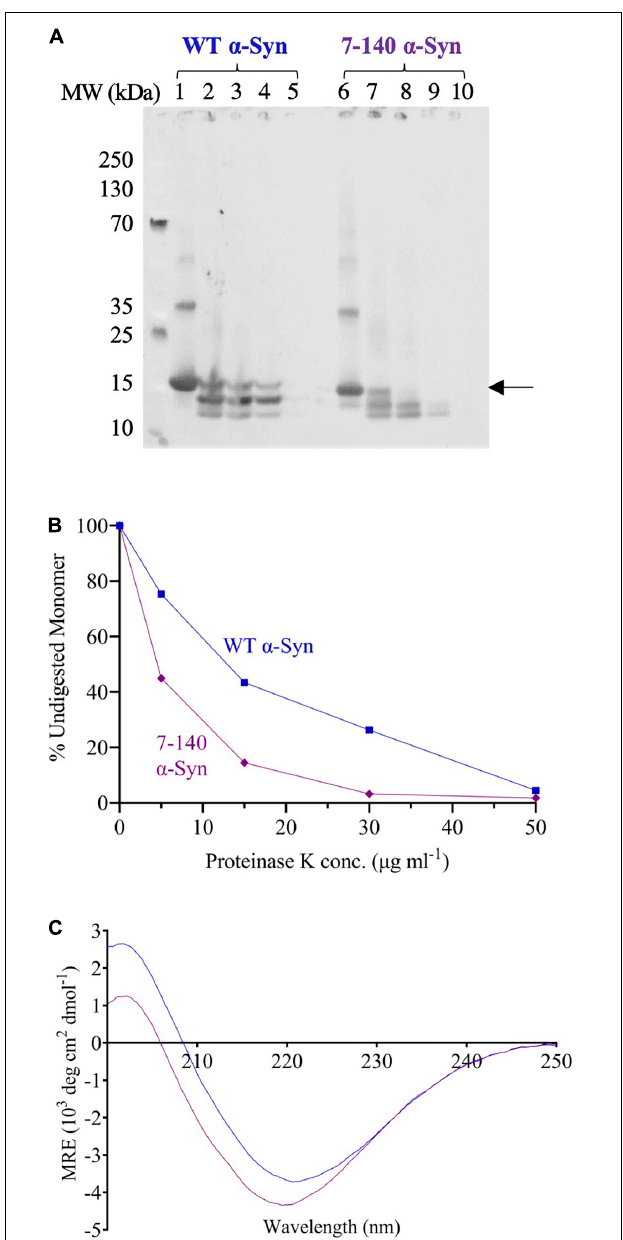
FIGURE 5 | (A) Proteinase K digestion of WT (lanes 1–5) and 7–140 (lanes 6–10) α -syn fibrils incubated with 0, 5, 15, 30, and 50 µ g/ml proteinase K, respectively. The arrow indicates the band that has been quantified and plotted. A representative experiment is shown. (B) The percentage of undigested monomeric WT (blue) and 7–140 (purple) α -syn at various protease concentrations. (C) CD spectra of WT (blue) and 7–140 (purple) α -syn fibrils. A representative spectrum for each variant is